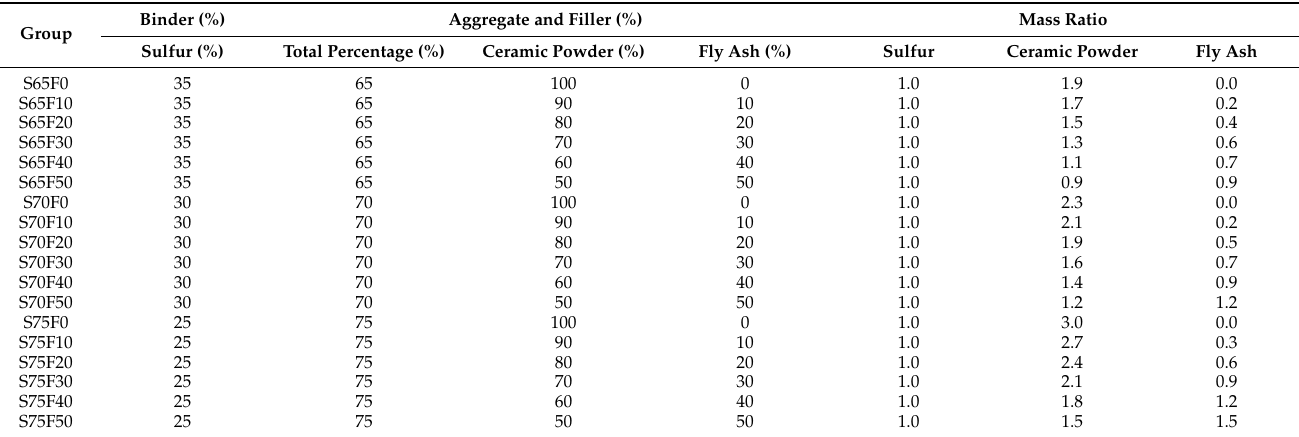
Table 5. Mix proportions of the tested